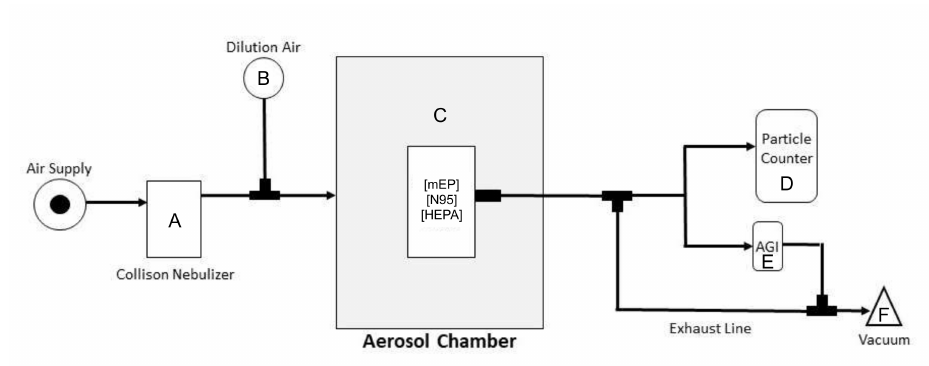
Figure 2. Configuration of exposure system used with SARS-CoV-2 bioaerosol evaluation. The air supply to the system was maintained at >40 PSIG and at ~21 PSIG to the nebulizer ( A ) which generated ~7 LPM at this pressure and dilution air ( B ) providing auxiliary air flow for mixing at 9 LPM. The total flow into the chamber was 16 LPM. The 16 L volume aerosol chamber ( C ) was dynamically operated with a constant flow of nebulized aerosol particles within the combination flow provided by the nebulizer and dilution air. Each device or filter was held in the center of the chamber by a modified ring stand, and the distal portion of each respirator sealed only the sampling port within the chamber in discrete experiments. An inlet for sampling by the particle counter ( D ) or AGI aerosol sampler ( E ) at an exhaust flow of either 5 or 6 LPM, respectively, was actuated at separate times, and residual exhaust, especially when the sampler was disengaged, provided a complete exhaust flow of 16 LPM ( F ). The entire system was expertly controlled using the AeroMP automated aerosol exposure system